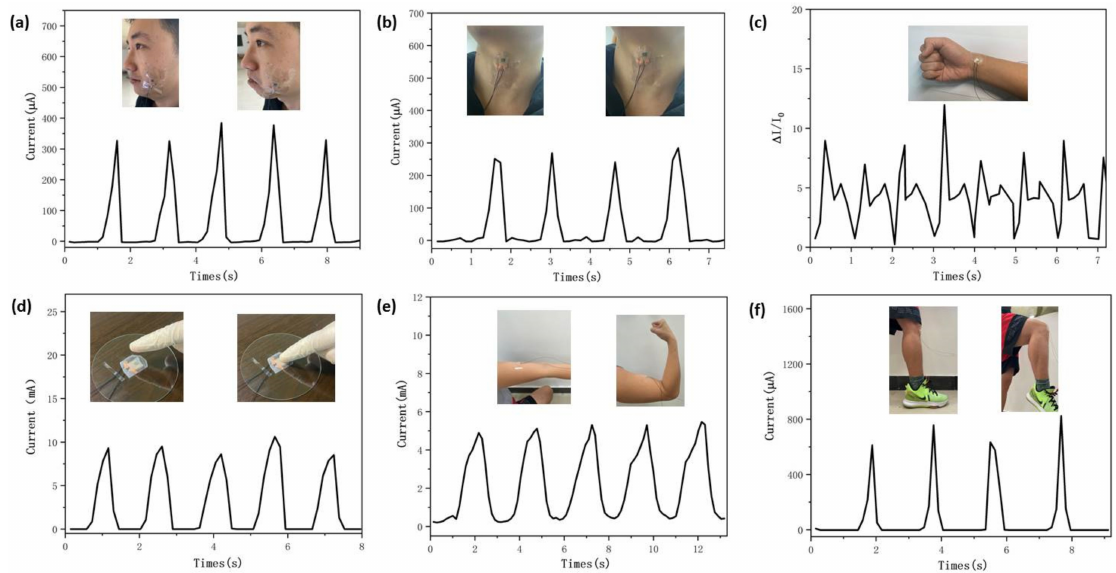
Figure 5. Applications of designed flexible piezoresistive sensors. The I-T curves of ( a ) cheek bulging, ( b ) throat swallowing, ( c ) pulse, ( d ) finger touching, ( e ) arm bending, and ( f ) knee